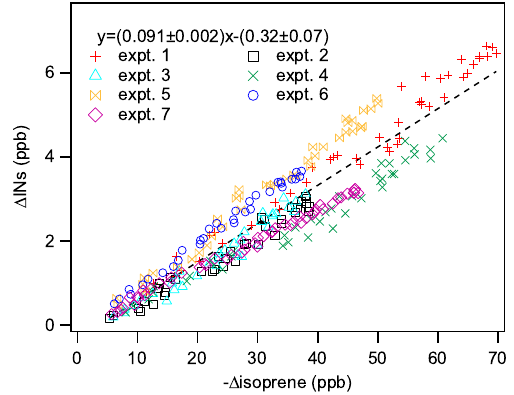
Figure 3. IN and isoprene data for chamber experiments. An aver- age yield of 9% was obtained from data of the seven